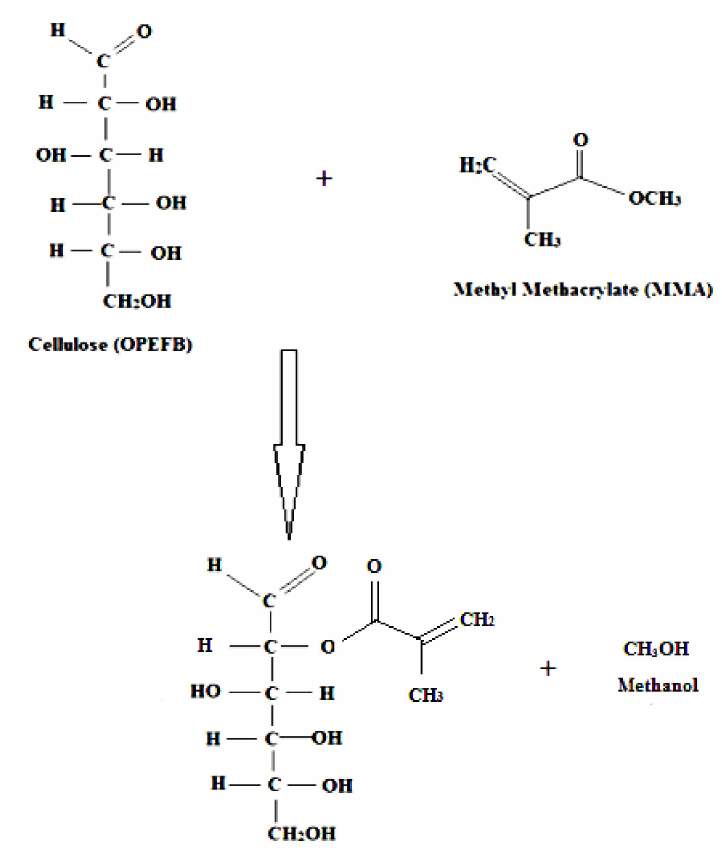
Figure 9. The schematic reaction between EFB and